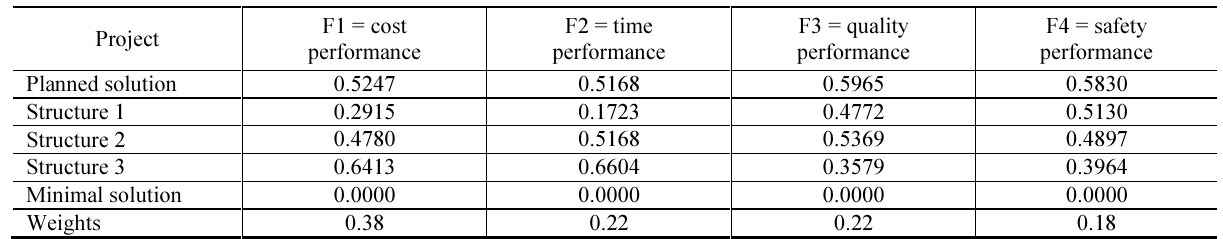
Table 6. Matrix of normalized values